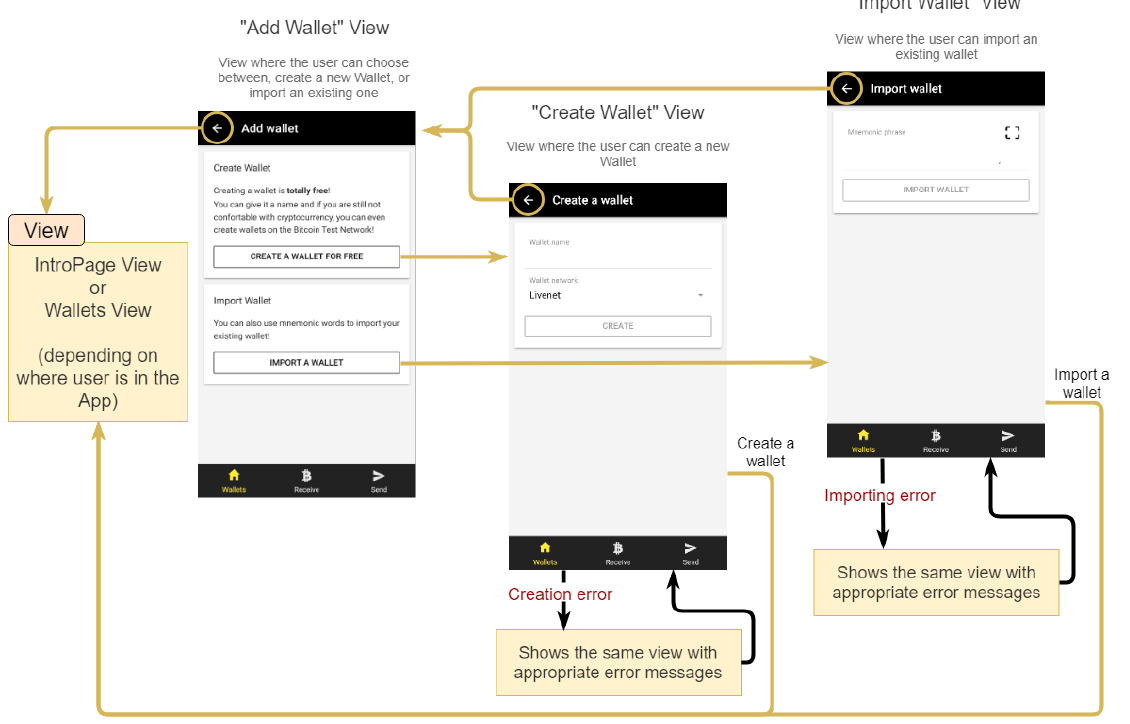
Figure 7. Navigability diagram of the “Add Wallet” view.